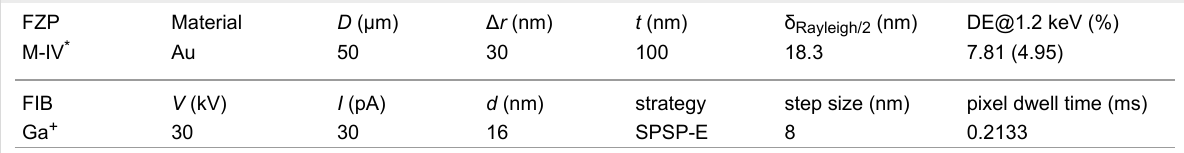
Table 1: Overview of the FZP and ion beam lithography process parameters. a